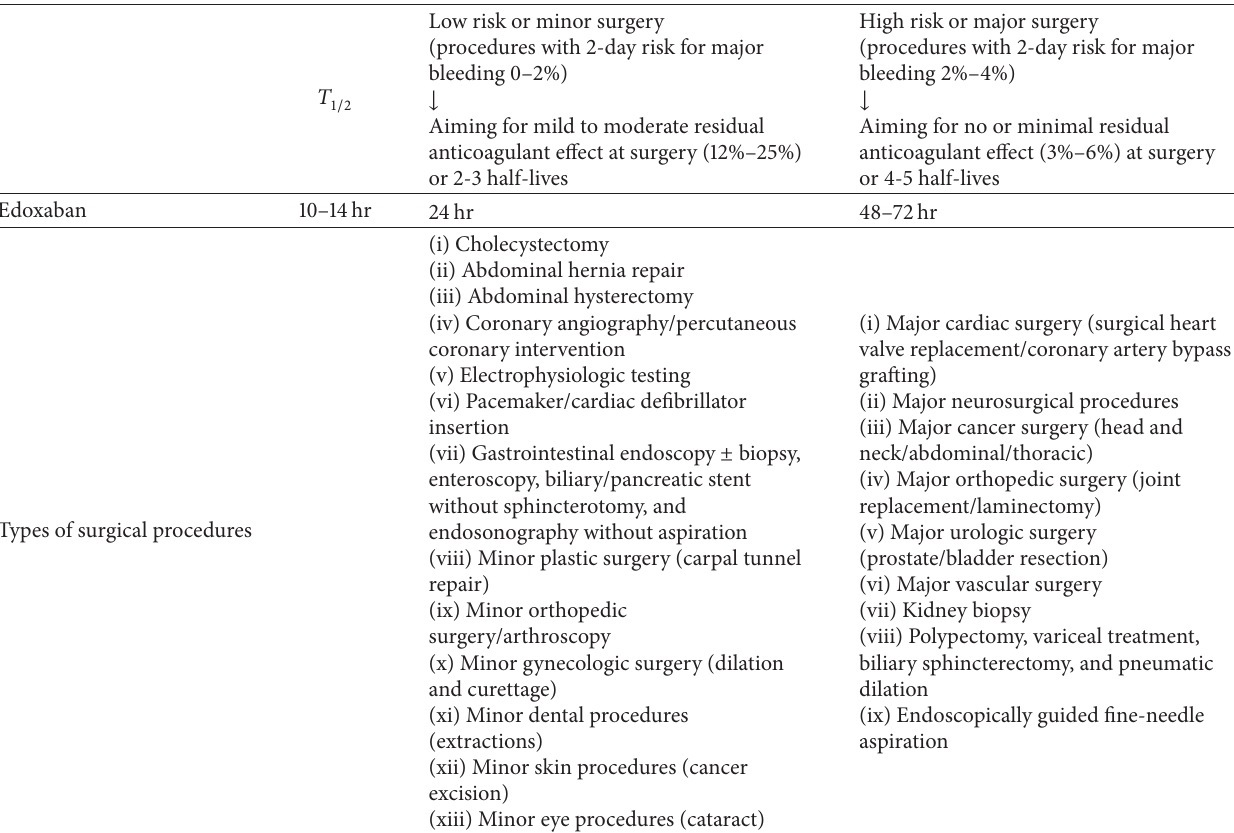
Table 3: Interruption/holding of edoxaban for procedures [17, 30,